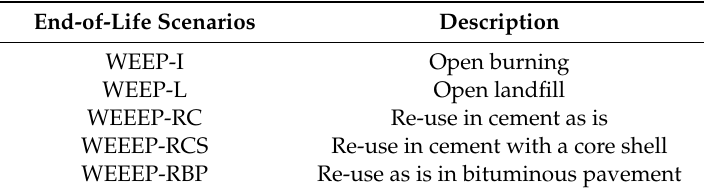
Table 3. Built end-of-life